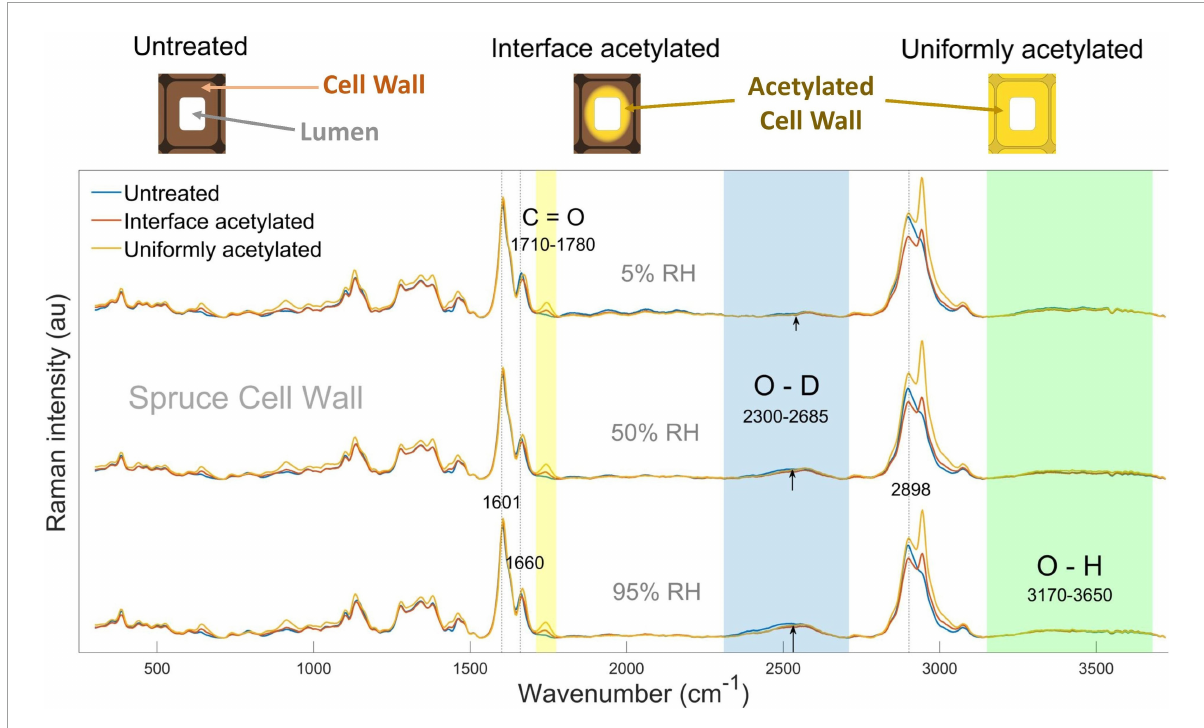
FIGURE1 In the top, schematic representations of untreated, interface and uniformly acetylated cell walls are shown. Below, average Raman spectra calculated for untreated (blue), interface acetylated (red), and uniformly acetylated (yellow) spruce cell walls (i.e., CELL WALL cluster), conditioned in D 2 O vapor at 5% (top), 50% (middle), and 95% RH (bottom). Wavenumber regions of interest assigned to acetylation, moisture, and water-inaccessible hydroxyls are shaded, respectively, in yellow, blue, and green. Peaks of interests are also highlighted by dotted lines, and marked with their exact wavenumber. The spectra for pyridine control samples are omitted for clarity as they were similar to the untreated wood, see Supplementary Figure 2